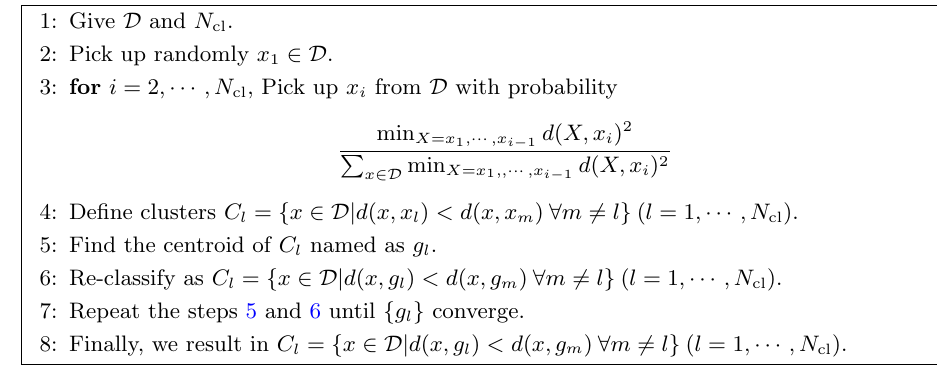
Algorithm 2 . K-means++